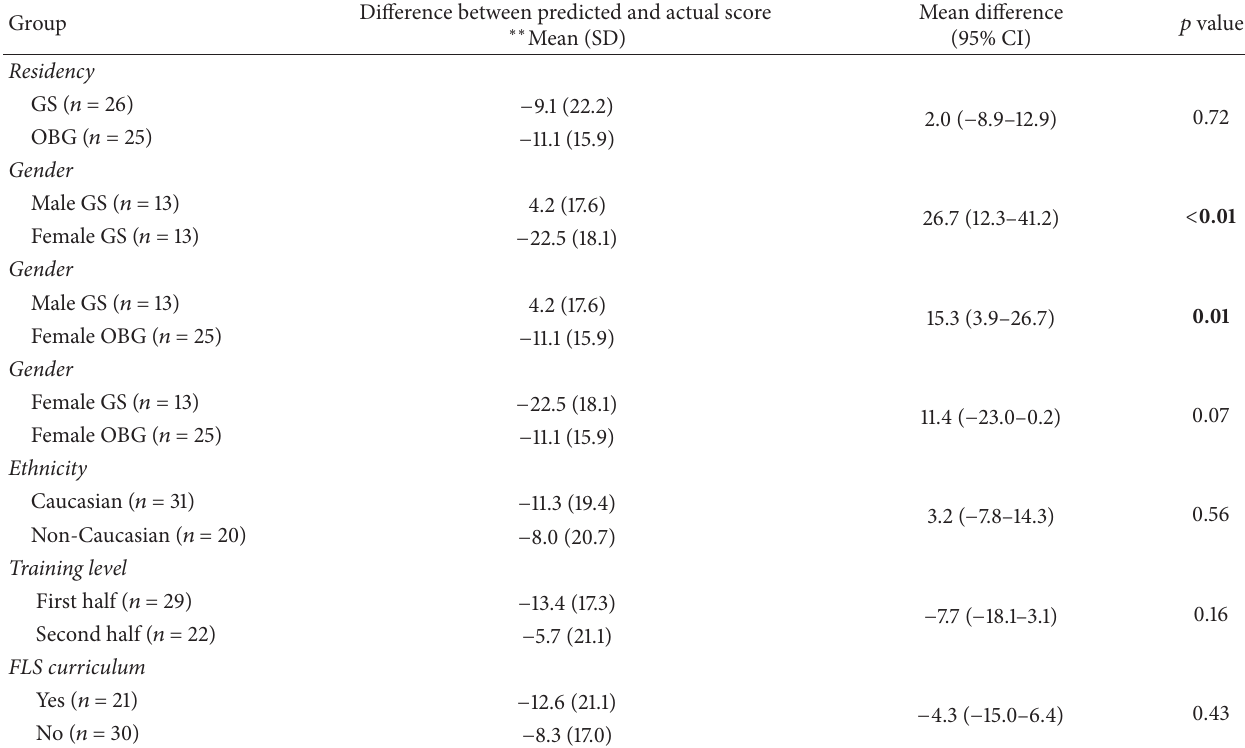
Table 4: Delta scores.